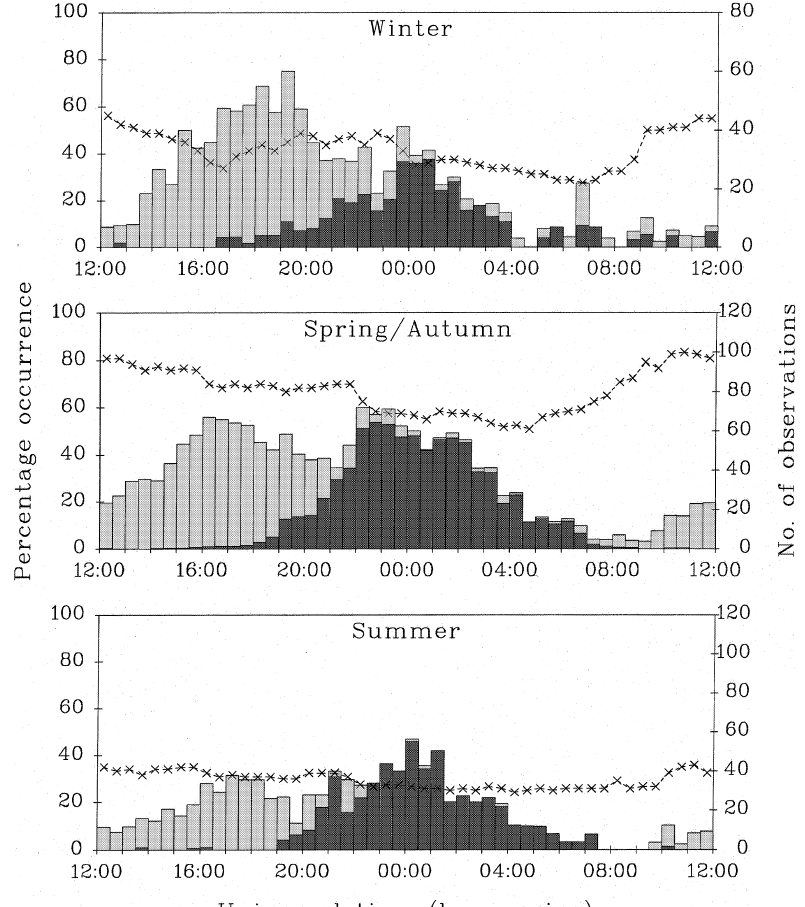
Fig. 6. Seasonal variation of the diurnal distri- bution of enhanced F-region ion velocity. The format of each panel is as for